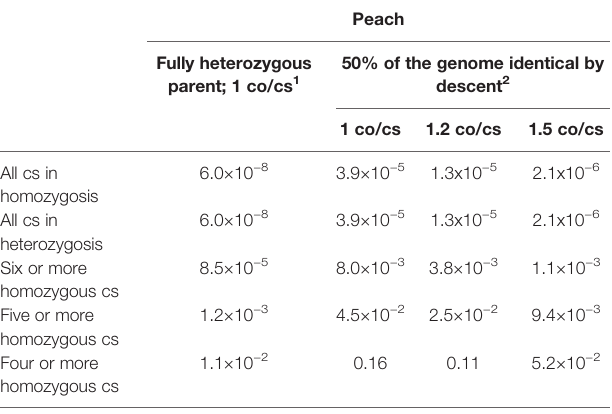
TABLE 1 | Approximate probabilities of fi nding a progeny homozygous (or heterozygous) for various intact chromosomes (cs) in the selfed progeny of peach ( x=8